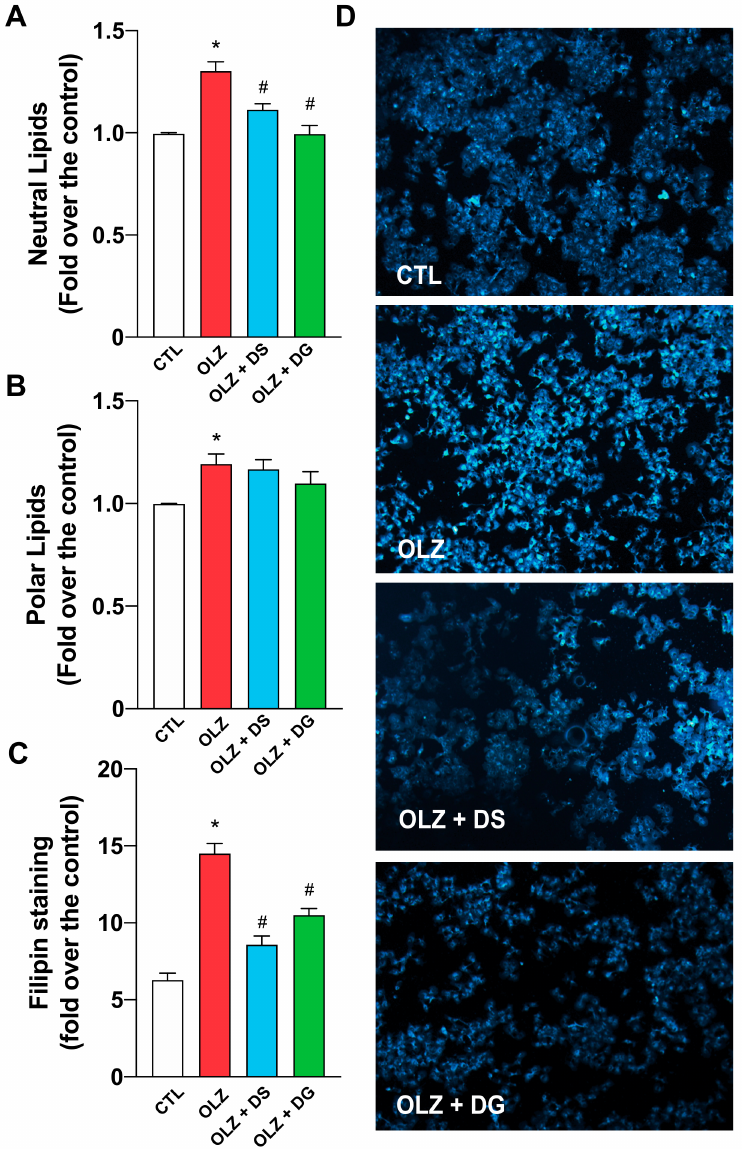
Figure 3. Response of DG and DS over lipid accumulation in HepG2. ( A ) Cells treated with OLZ plus DS or DG show a significant decrease in the accumulation of neutral lipids. ( B ) Cells treated with OLZ plus DS or DG did not show a protective effect against the accumulation of polar lipid induced by OLZ ( C ) DS, and DG prevented the accumulation of unesterified cholesterol induced by OLZ. * p < 0.05 vs. CTL. # p < 0.05 vs. OLZ ( D ) Representative images were visualized by fluorescence microscopy with a 10X objective. White bars represent control (CTL); red bars represent olanzapine (OLZ)-treated cells, blue bars represent the olanzapine and delphinidin-3-sambubioside- 5-glucoside (DS) treatment, and green bars represent the olanzapine and delphinidin-3,5-diglucoside (DG)